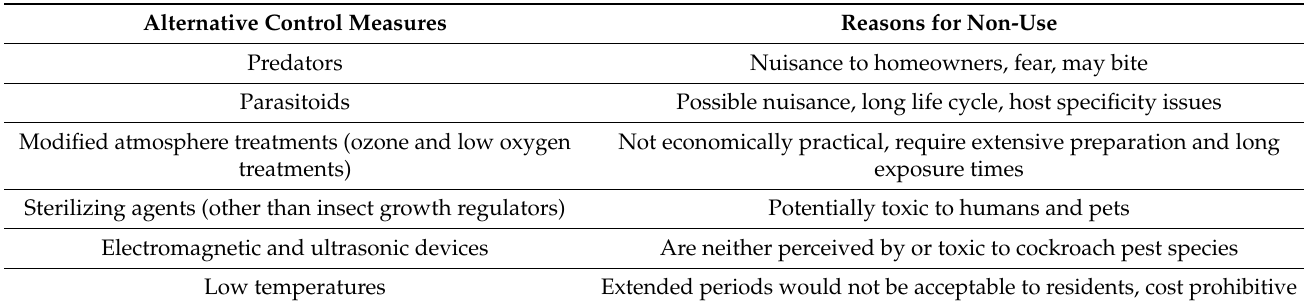
Table 2. A list of alternative German cockroach control strategies that are not currently used in IPM programs. See Schal [10], Gold [13], and Rust [32] for a detailed description of these alternative control